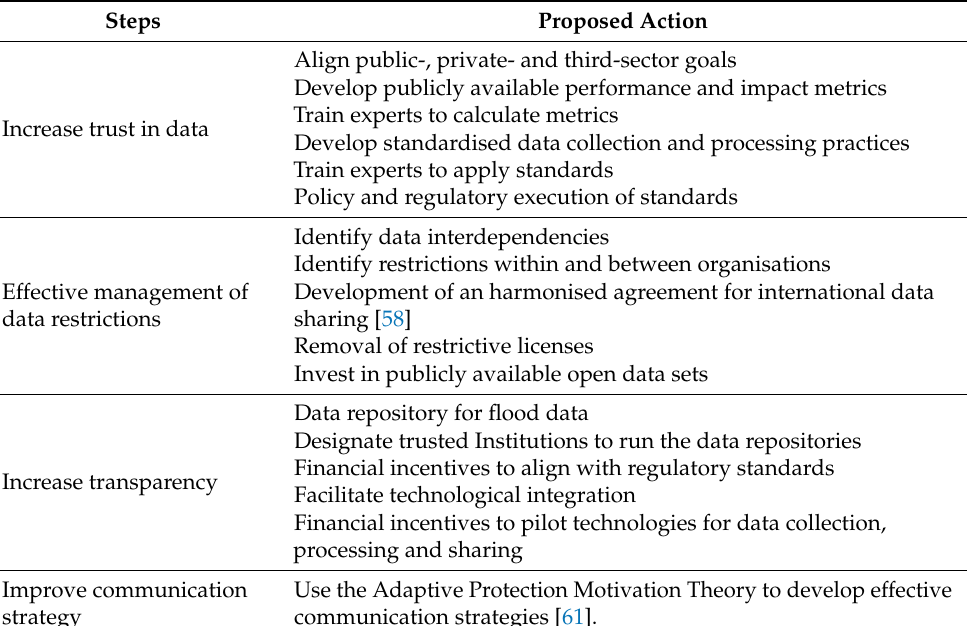
Table 2. Proposed steps and actions to develop a data trust for geospatial and flood resilient